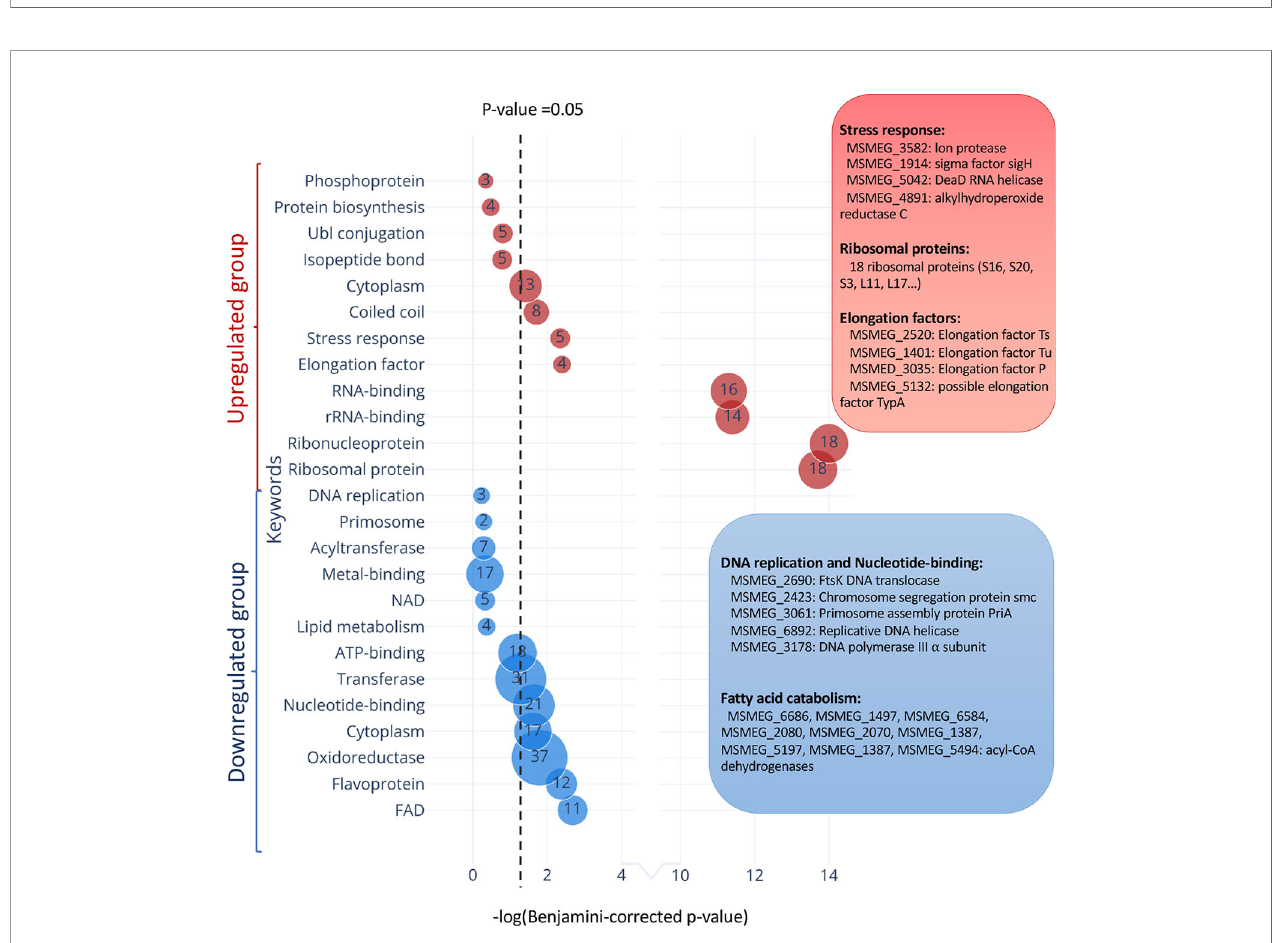
FIGURE 7 | Functional classi fi cation of differentially translated proteins during MazF-ms expression. Enriched DAVID UP_KEYWORDS (corresponding to UniProt keywords) were generated by analyzing the upregulated (red) or downregulated (blue) proteins identi fi ed in azidohomoalanine (AHA)-proteomics. The diameter of each circle and its numbering correspond to the number of genes associated with the given keyword. Examples of genes in the main groups are described by relevant categories in the corresponding color-matched